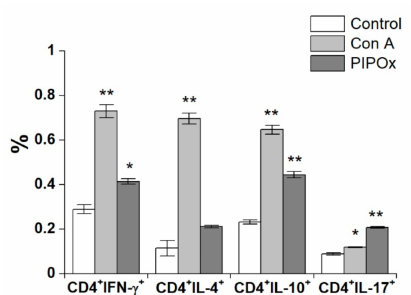
Figure 5. Flow-cytometric analysis of cytokine producing CD4 + lymphocytes. Distribution of IFN- γ , IL-4, IL-10 and IL-17 producing CD4 + cells within spleen cells stimulated with Con A (10 µ g/mL) and PIPOx (5 mg/mL). Tests were done in triplicate. The experimental data are expressed as geometric means of three replicates ± SD. Levels of significance: ** 0.001 < p < 0.01, * 0.01 < p < 0.05. Differences were considered significant at 0.01 < p <